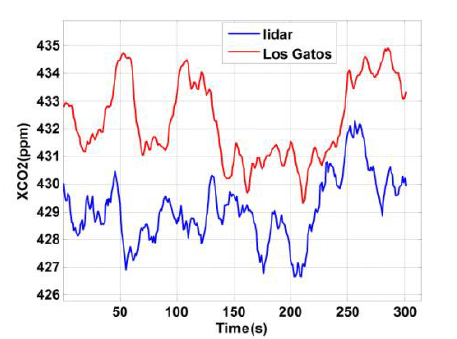
Figure 9 Comparison of XCO2 measured by lidar and Los Gatos in-situ analyzer